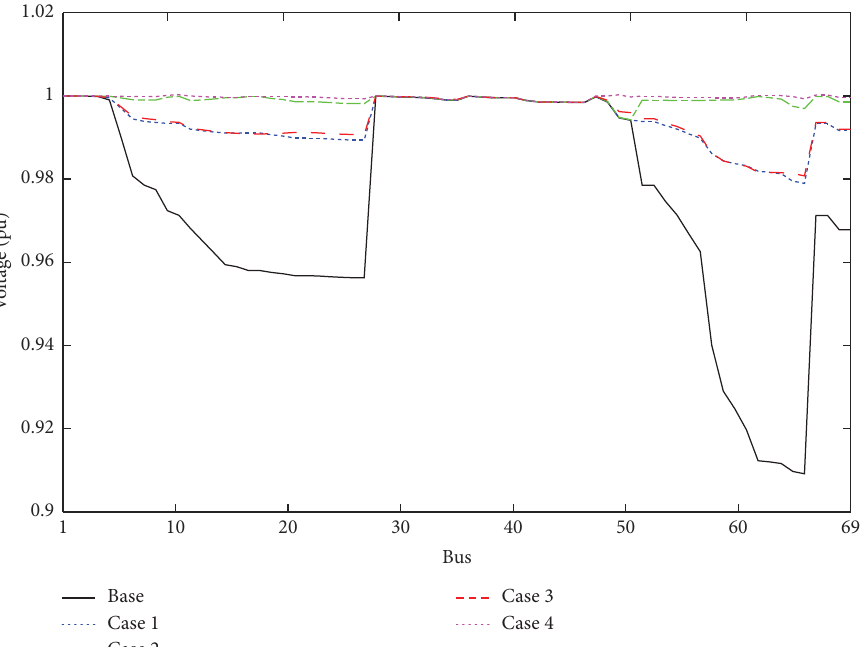
Figure 10: Comparison of voltage profles for system